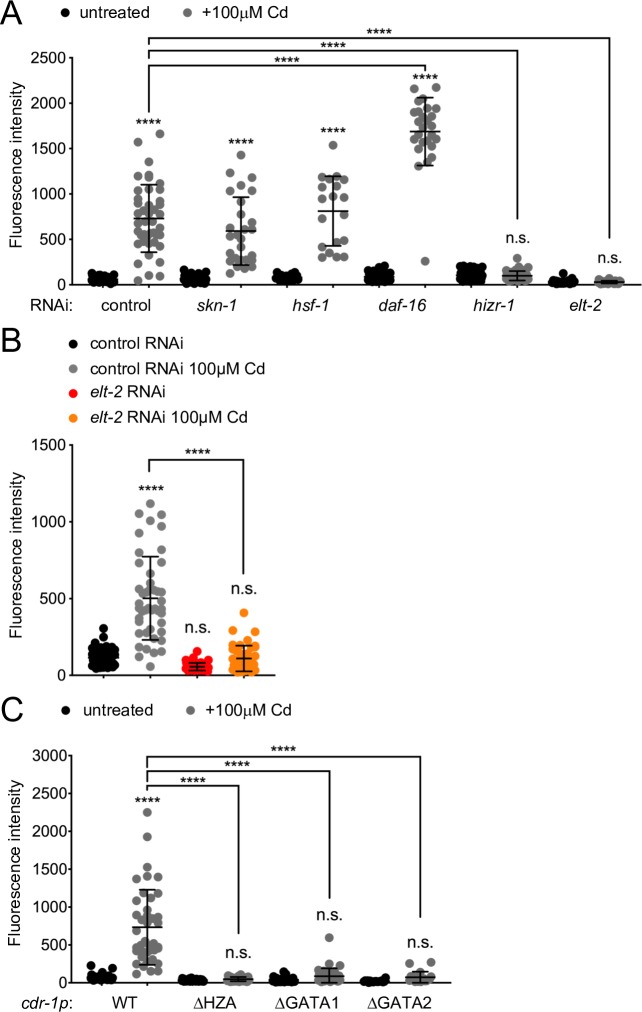
The TFs hizr-1 and elt-2 and their cognate promoter elements are required for the cadmium stress responses.[A] The graph shows the average fluorescence intensity (arbitrary units, A.U.) of worms bearing the cdr-1p::gfp transcriptional reporter before and after a 0μM or 100μM cadmium (Cd) exposure (four hours), and fed either control or transcription factor RNAi, as indicated (control RNAi 0μM Cd: n = 51 worms total from 4 independent repeats; control RNAi 100μM Cd: n = 43 worms total from 4 independent repeats; skn-1 RNAi 0μM Cd: n = 39 worms total from 3 independent repeats; skn-1 RNAi 100μM Cd: n = 27 worms total from 3 independent repeats; hsf-1 RNAi 0μM Cd: n = 22 worms total from 2 independent repeats; hsf-1 RNAi 100μM Cd: n = 19 worms total from 2 independent repeats; daf-16 RNAi 0μM Cd: n = 27 worms total from 2 independent repeats; daf-16 RNAi 100μM Cd: n = 26 worms total from 2 independent repeats; hizr-1 RNAi 0μM Cd: n = 50 worms total from 3 independent repeats; hizr-1 RNAi 100μM Cd: n = 40 worms total from 3 independent repeats; elt-2 RNAi 0μM Cd: n = 22 worms total from 3 independent repeats; elt-2 RNAi 100μM Cd: n = 37 worms total from 3 independent repeats). Error bars: standard deviation. Statistical analysis: **** p < 0.0001, n.s. = not significant, two-way ANOVA, multiple comparisons, Tukey correction; comparisons are to control(RNAi) 0μM Cd unless indicated by lines. [B] The graph shows the average fluorescence intensity (arbitrary units, A.U.) of day-3 old adult worms bearing the cdr-1p::gfp transcriptional reporter, fed either control or elt-2 RNAi during the first two days of adulthood and then exposed to 0μM or 100μM cadmium (Cd) for four hours (control RNAi 0μM Cd: n = 48 worms total from 3 independent repeats; control RNAi 100μM Cd: n = 45 worms total from 3 independent repeats; elt-2 RNAi 0μM Cd: n = 48 worms total from 3 independent repeats; elt-2 RNAi on 100μMCd: n = 43 worms total from 3 independent repeats). Error bars: standard deviation. Statistical analysis: **** p < 0.0001, n.s. = not significant, two-way ANOVA, multiple comparisons, Tukey correction; comparisons are to control RNAi 0μM Cd unless indicated by lines. [C] The graph shows the average fluorescence intensity (arbitrary units, A.U.) of worms bearing the following cdr-1p::gfp reporter variants: wild-type, WT; mutated HZA element, cdr-1pΔHZA; mutated GATA elements, cdr-1pΔGATA1 or cdr-1pΔGATA2. All mutants were assessed after a four-hour 0μM or 100μM cadmium (Cd) exposure (WT 0μM Cd: n = 37 worms total from 4 independent repeats; WT 100μM Cd: n = 41 worms total from 4 independent repeats; cdr-1pΔHZA 0μM Cd: n = 42 worms total from 2 independent repeats; cdr-1PΔHZA 100μM Cd: n = 30 worms total from 2 independent repeats; cdr-1pΔGATA1 0μM Cd: n = 32 worms total from 3 independent repeats; cdr-1pΔGATA1 100μM Cd: n = 37 worms total from 3 independent repeats; cdr-1pΔGATA2 0μM Cd: n = 19 worms total from 2 independent repeats; cdr-1PΔGATA2 100μM Cd: = 19 worms total from 2 independent repeats). Error bars: standard deviation. Statistical analysis: **** p < 0.0001, n.s. = not significant, two-way ANOVA, multiple comparisons, Tukey correction; comparisons are to WT unless indicated by lines.